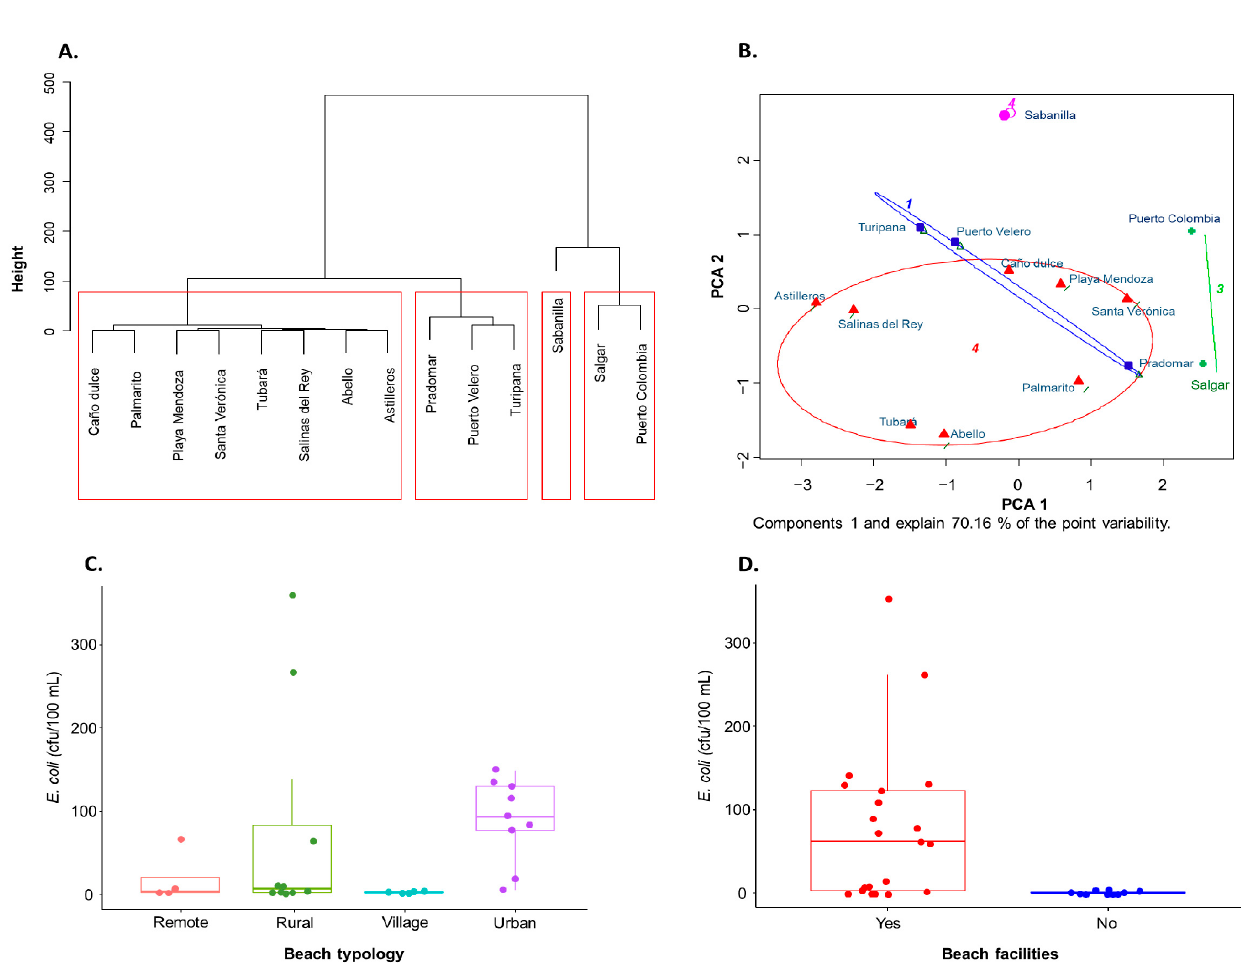
Figure 4. Clusters analysis grouping beaches according to microbiological parameters and beach characteristics. ( A ) Dendrogram of hierarchical clustering using Ward method. ( B ) Principal Components Analysis (PCA) calculated based on a Euclidian dissimilarity distance matrix. ( C ) Boxplot of E. coli counts according to beach typology. ( D ) Boxplot of E. coli counts according to presence or absence of beach facilities.